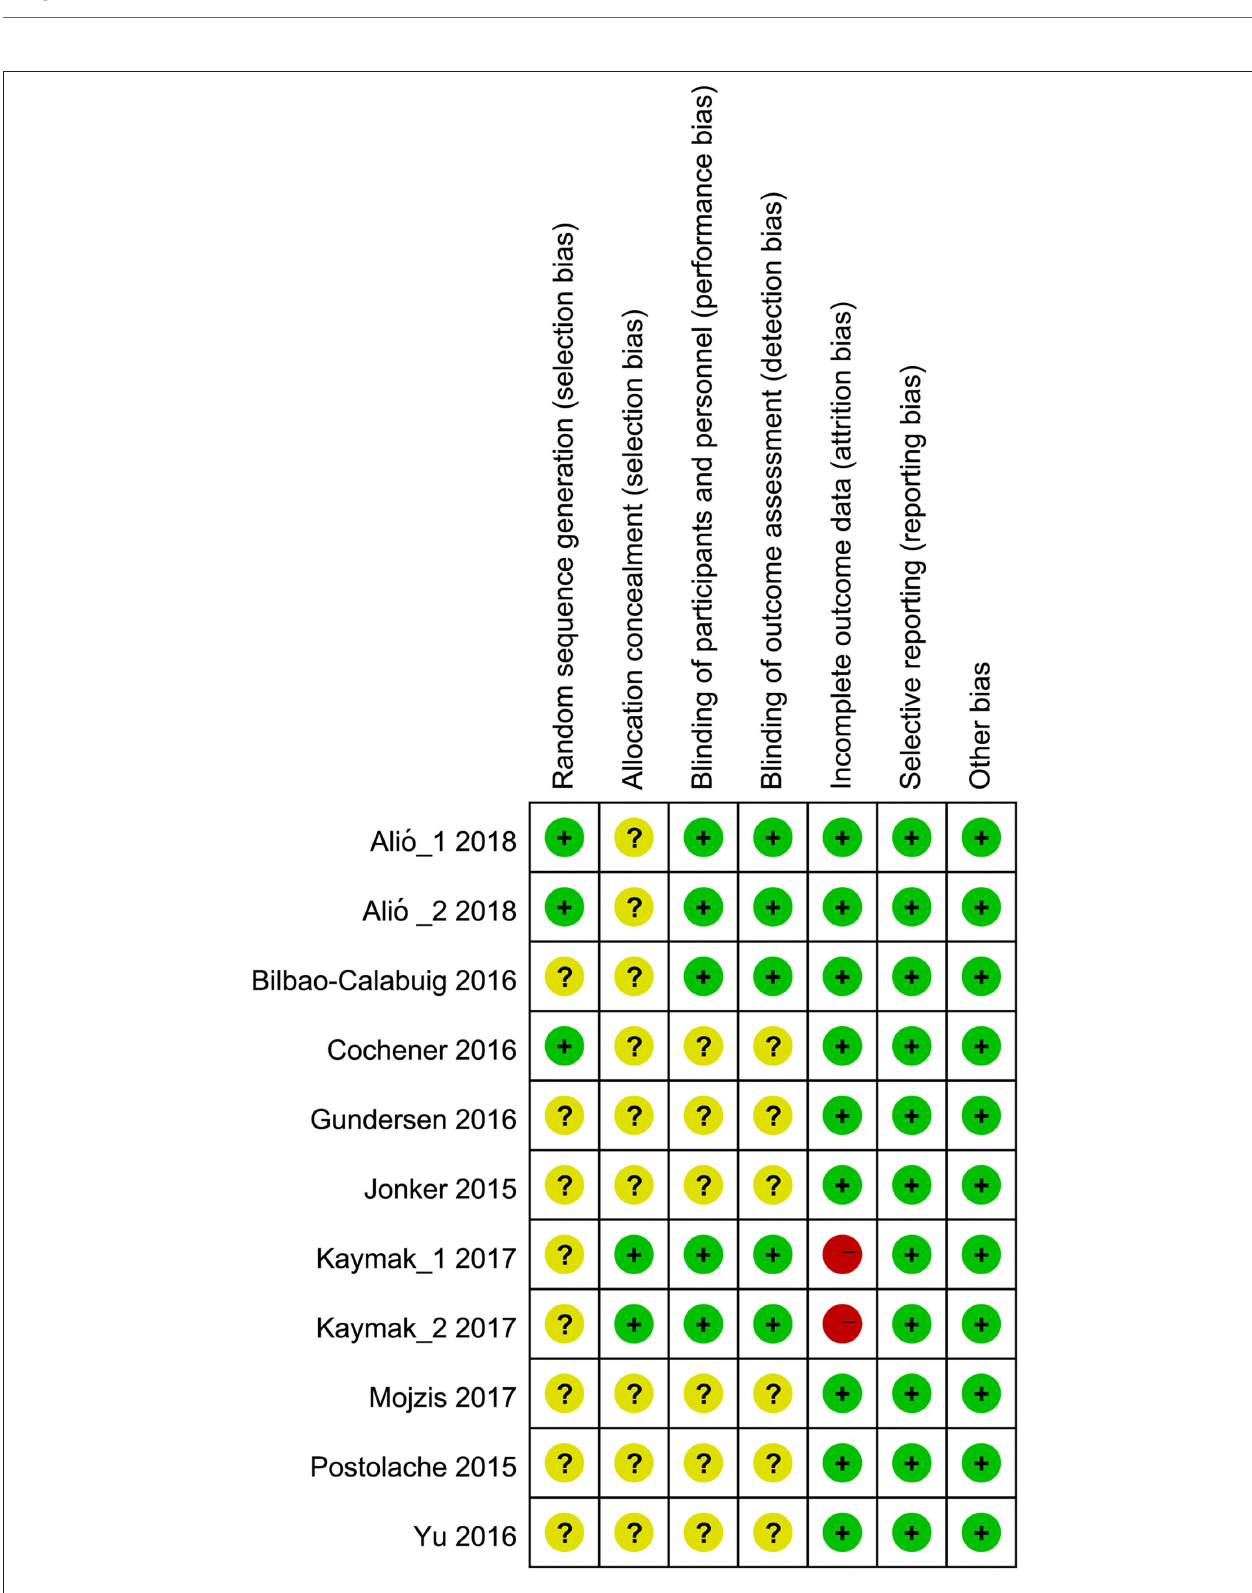
FIGURE 2 | Risk of bias summary. Green, yellow and red solid circles represented low, unclear and high risk of bias.